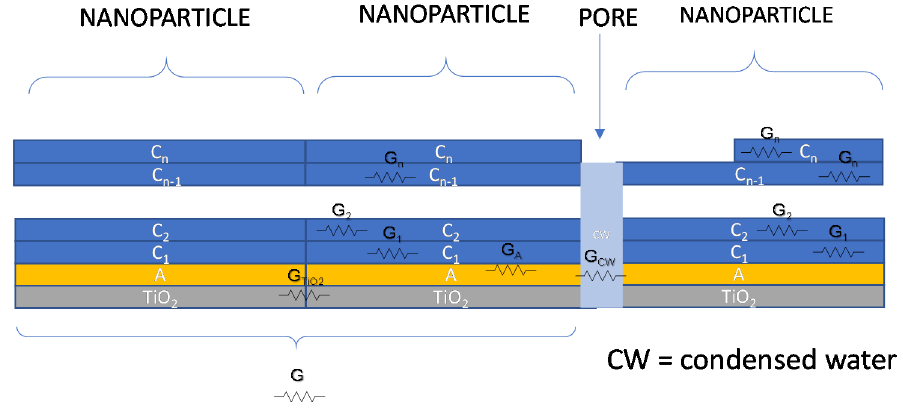
Figure 4. Contributions to charge transport phenomena for TiO 2 in a humid environment.